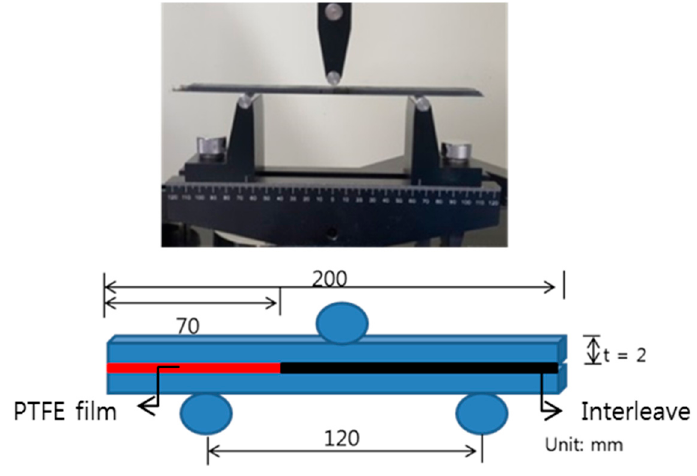
Figure 1. Experimental setting of ENF test. Table 2. Average mode II interlaminar fracture toughness ( 𝐺 (cid:3010)(cid:3010)(cid:3004) ) values.